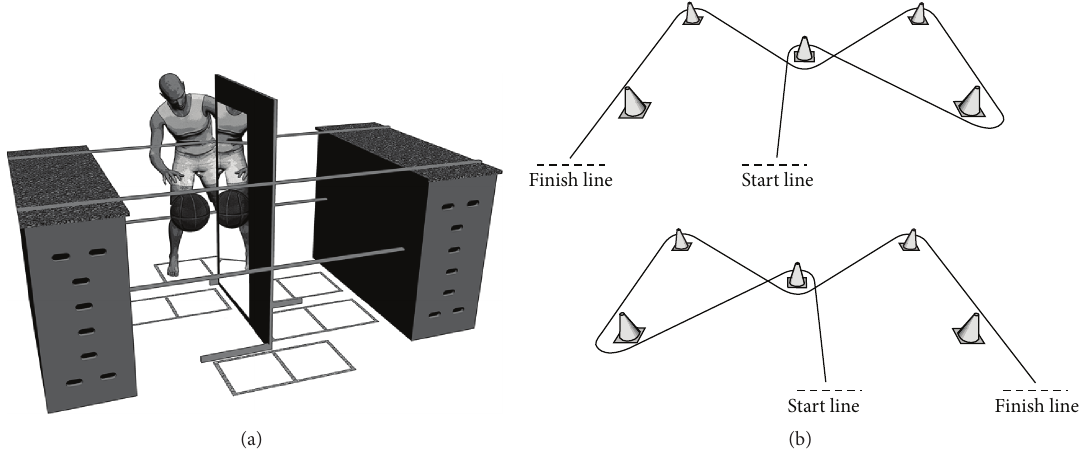
Figure 1: (a) The mirror box apparatus with the mirror being in the midsagittal plane of a participant; details in the text. (b) The slalom course setup for right hand dribbling (bottom) and for left hand dribbling